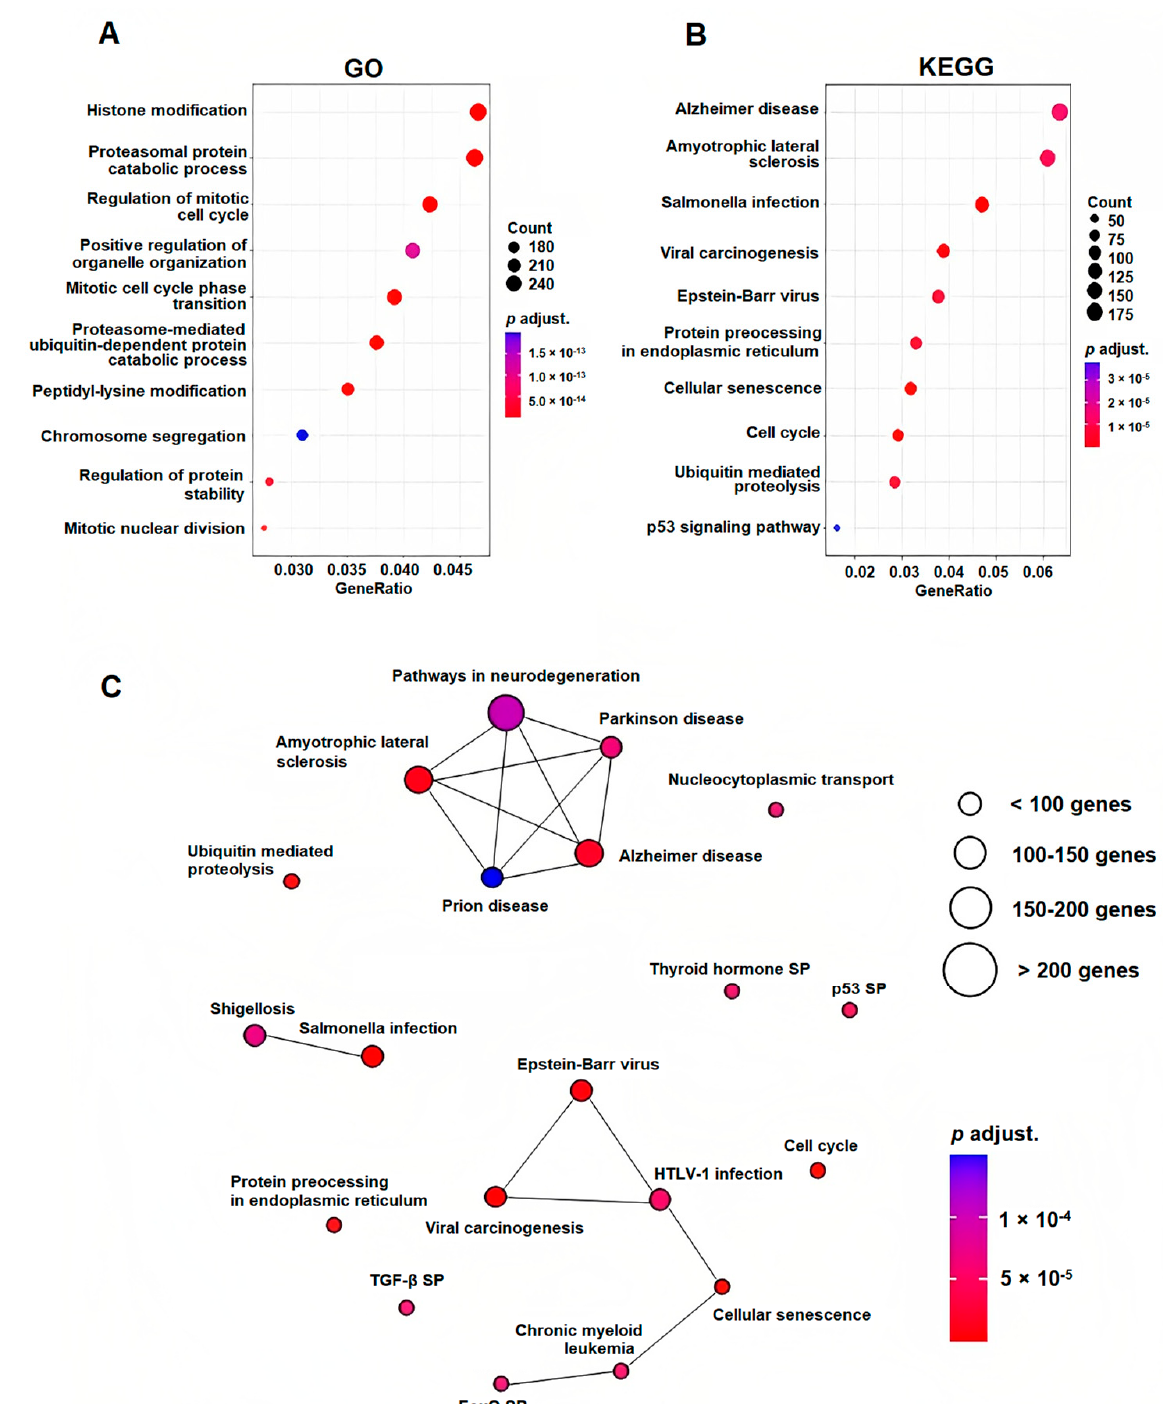
Figure 4. Functional annotation and pathway enrichment analysis. ( A ) Ten most enriched biological processes based on the GO classification. ( B ) Ten most enriched signaling pathways based on the KEGG analysis. ( C ) Signaling pathways interaction network based on the 20 most significant signaling pathways defined by KEGG. ALS—Amyotrophic lateral sclerosis, SP—signaling pathway, EB—Epstein–Barr virus, HTLV-1—Human T-cell leukemia virus 1, ER—endoplasmic reticulum, CML—chronic myeloid leukemia.